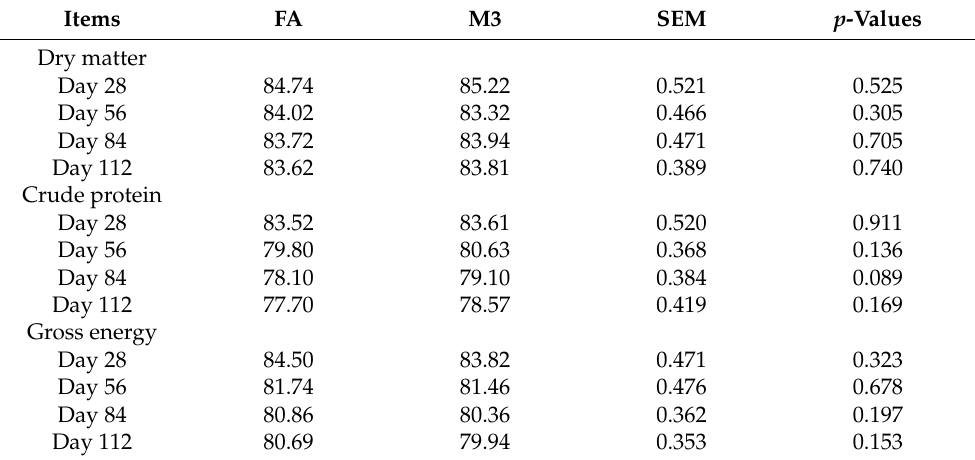
Table 4. Effects of feeding frequency on nutrient digestibility in growing–finishing pigs.